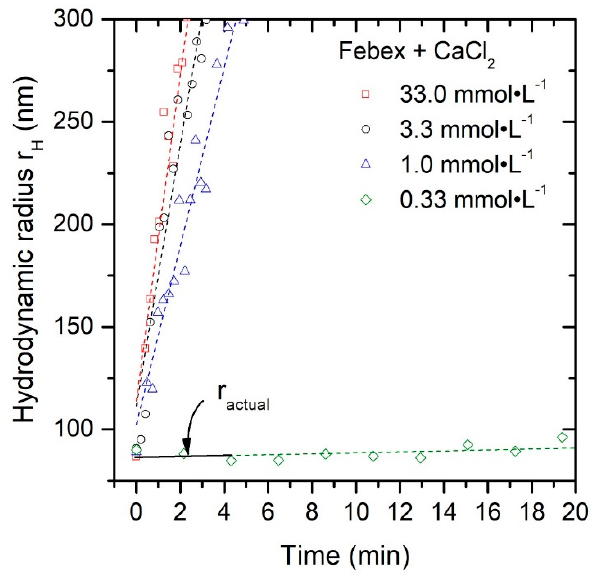
Figure 1. Time-dependent hydrodynamic radius r H increase for FEBEX bentonite colloids as a function of CaCl 2 background electrolyte concentration at pH 8. The actual coagulation rate (r actual ) of doublet formation is defined as slope of the time-dependent change of the average colloid hydrodynamic radius.